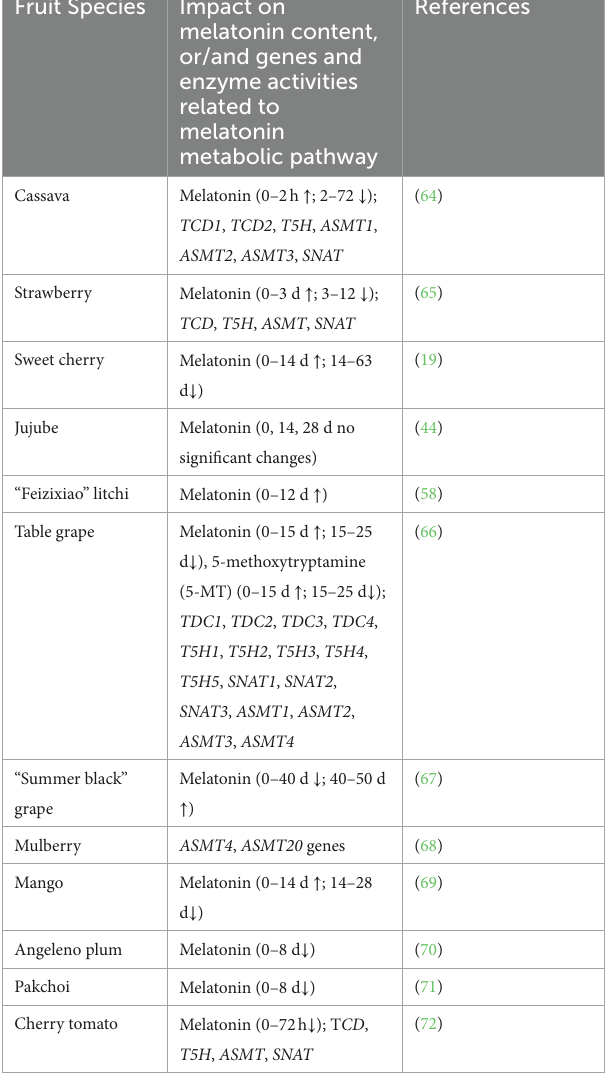
TABLE 1 Summary table explaining the changes of melatonin content, and genes related to melatonin metabolic pathway in fruits and vegetables during the postharvest